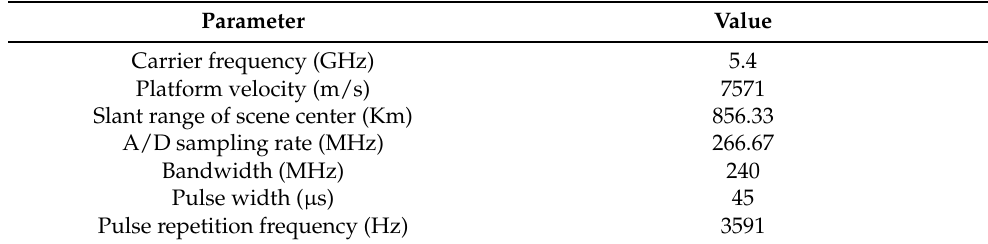
Table 3. The system parameters of Gaofen-3.